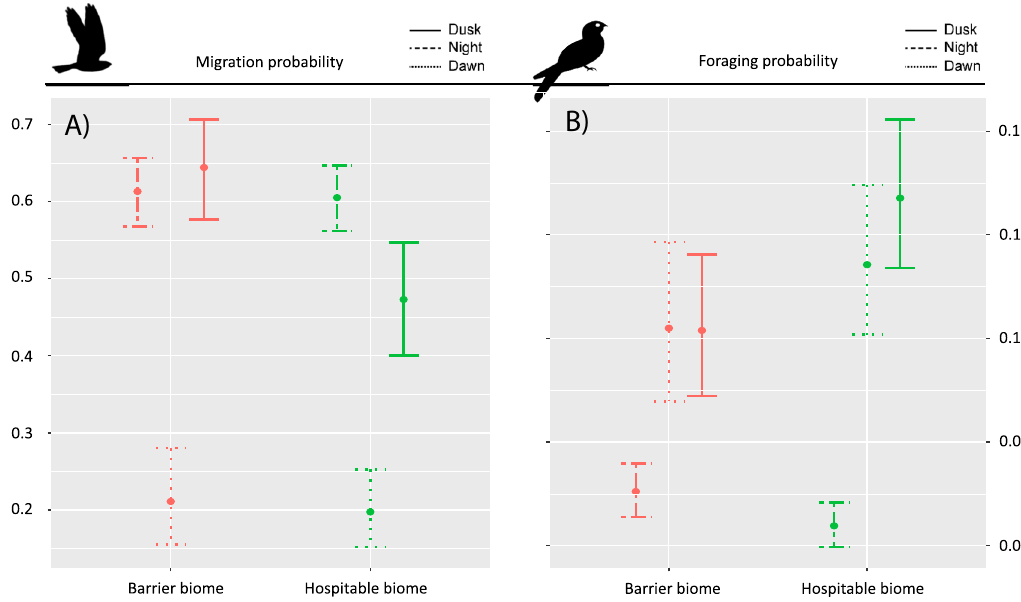
Figure 2. Differences in migration ( A ) and foraging probability ( B ) in barrier (red) or hospitable (green) biomes during dusk (solid line), night (dashed line) and dawn (dotted line). n = 53,556 5-min intervals; 5 individuals. Shown are model estimates and their 95% confidence intervals based on the model results in Table 1.